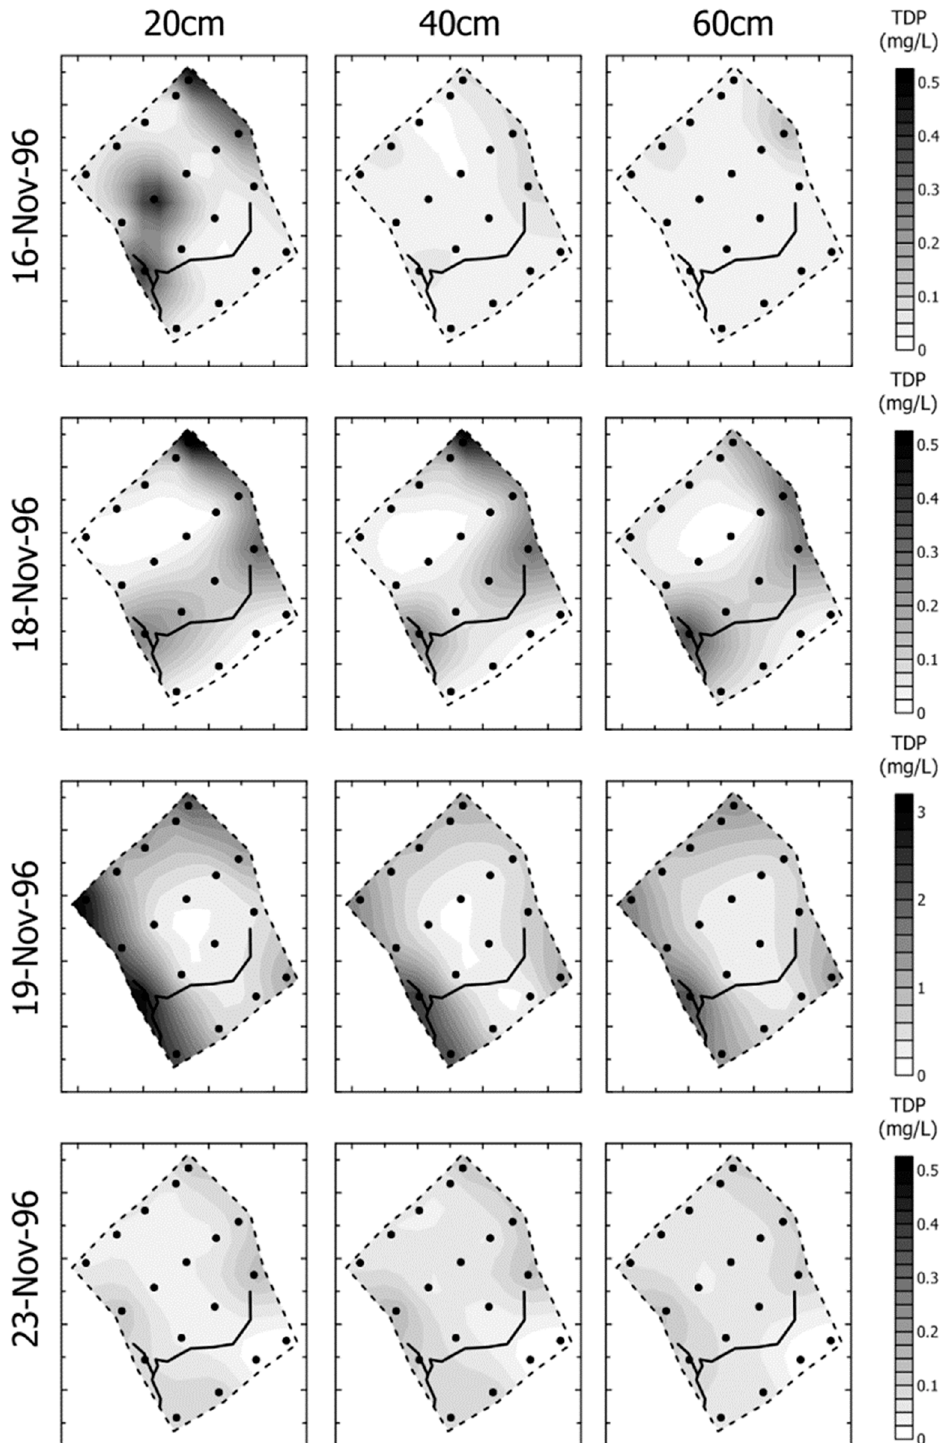
Figure 12. Total dissolved P (TDP) dynamics under storm conditions, 16 November 1996 to 23 November 1996. Note that the scale varies the over course of the event.